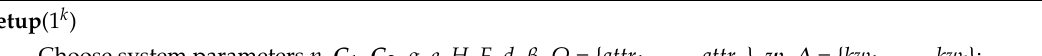
Table 2. The pseudo-code of the proposed